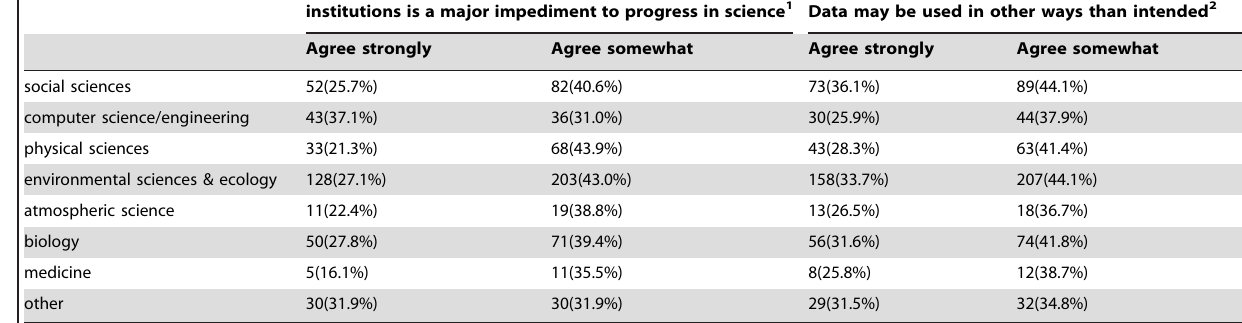
Table 18. Data reuse by subject